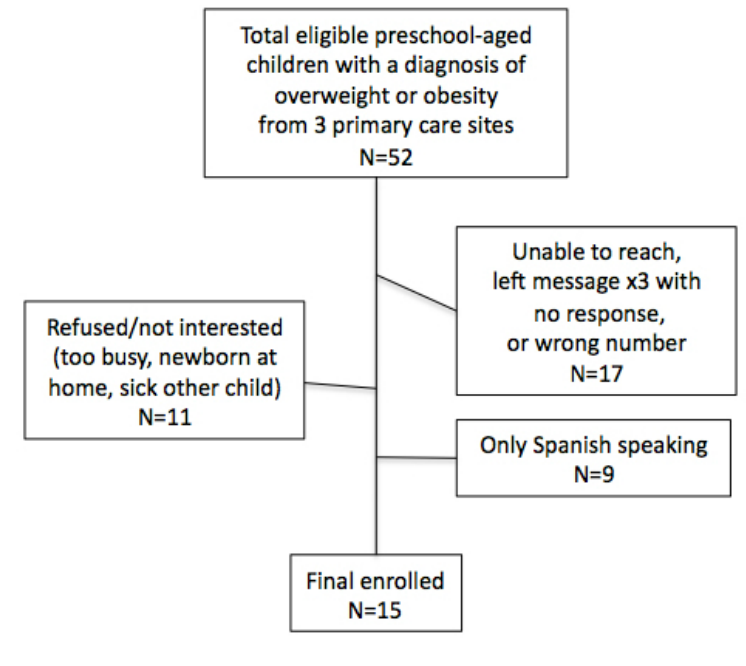
Figure 3. Flow diagram of participant